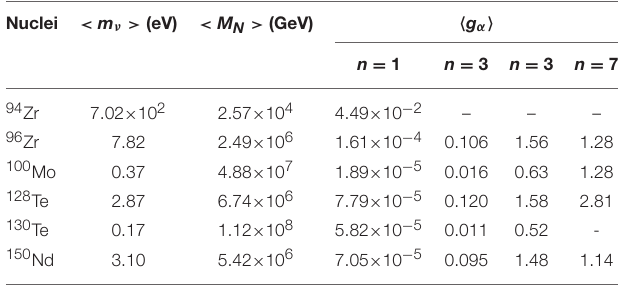
TABLE 10 | Extracted effective light Majorana mass < m ν > , effective heavy Majorana mass < M N > , effective Majoron-neutrino